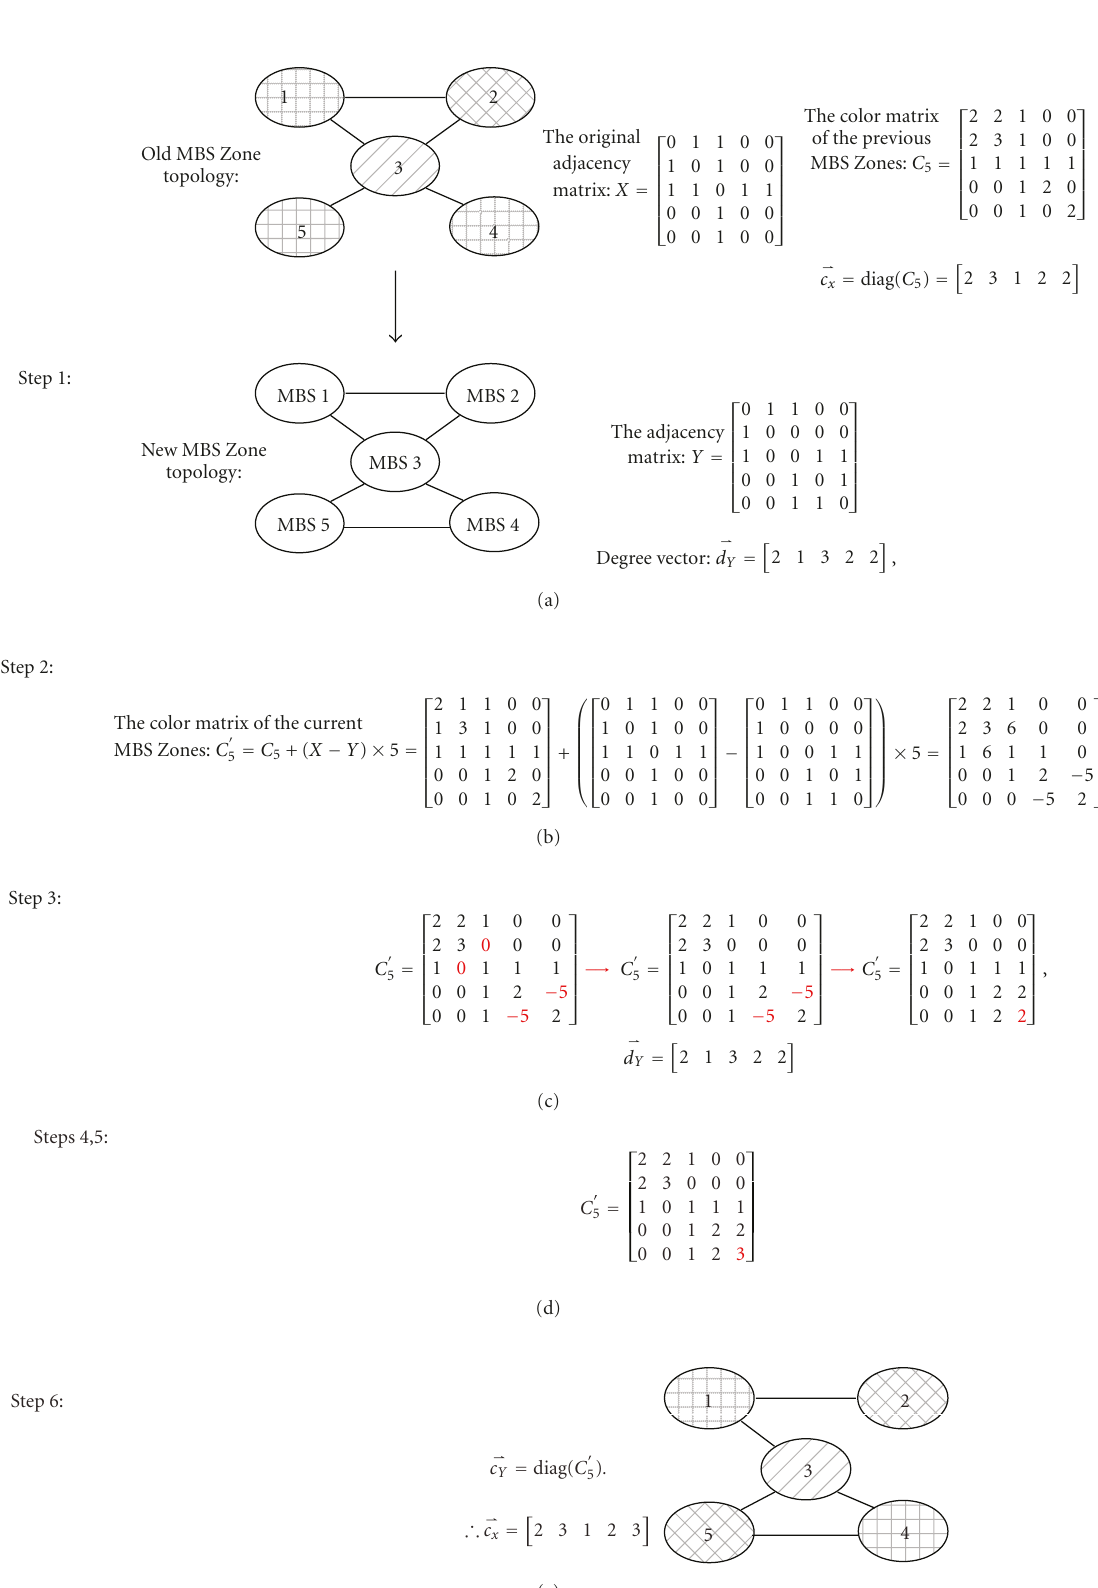
Figure 4: The procedure of the radio resource reallocation